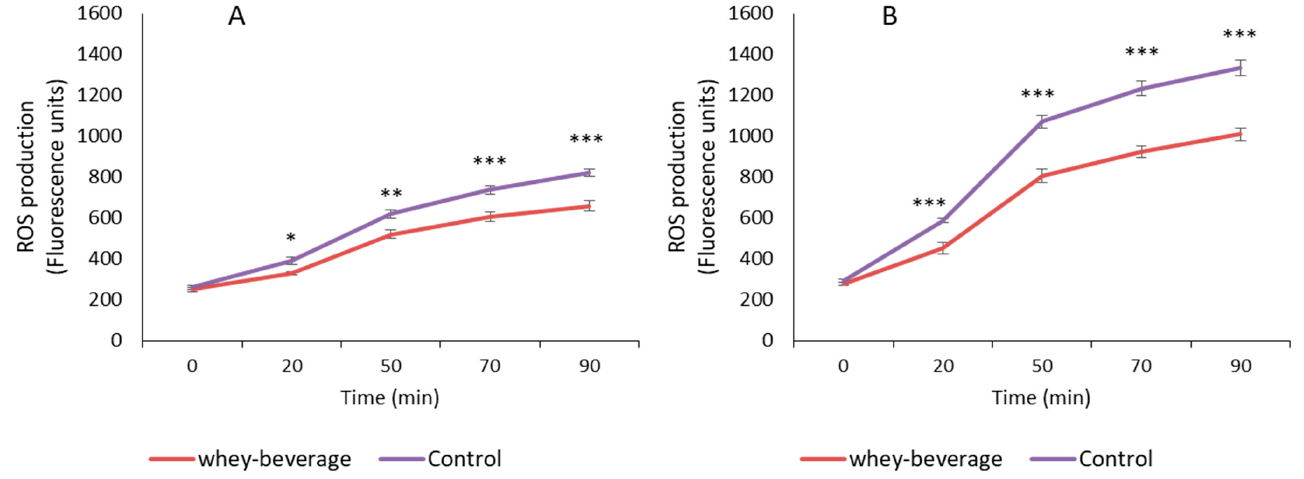
Figure 4. ROS generation expressed as fluorescence units during 90 min (mean ± SE) in Caco-2 cells pre-incubated with BF of the whey beverage compared with control cells incubated with culture medium. ( A ) Basal conditions. ( B ), oxidative stress induced with t-BOOH 10 mM. *, p < 0.05; **, p < 0.01; ***, p < 0.001.